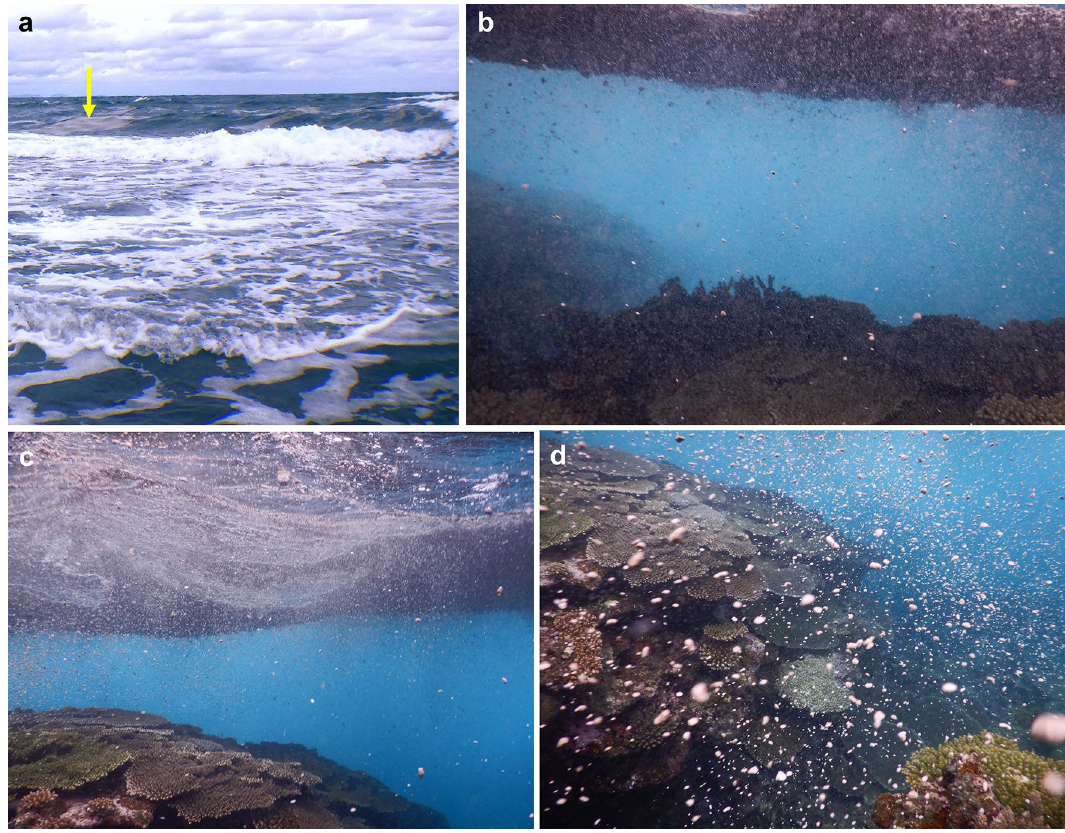
Figure 6. Pumice raft shading corals at the reef edge. Pumice rafts shading corals at the reef-edge (Iji coastal area: 26°46 ′ 00.2 ″ N, 128°11 ′ 35.3"). Photos were taken at low tide during the day on 14 November 2021, and the pumice raft floated approximately 50 cm from the top of the reef (see Supplementary Video 3). ( a ) View of the reef edge from the intertidal zone at low tide. The yellow arrow indicates that the pumice raft was drifting across the reef edge. ( b ) It was dark under the pumice rafts. ( c ) The pumice rafts were shown to disperse as the waves came in, allowing sunlight to reach the coral through their gaps. ( d ) The waves crashed the pumice rafts, causing countless pumice stones to drift fast through the water.